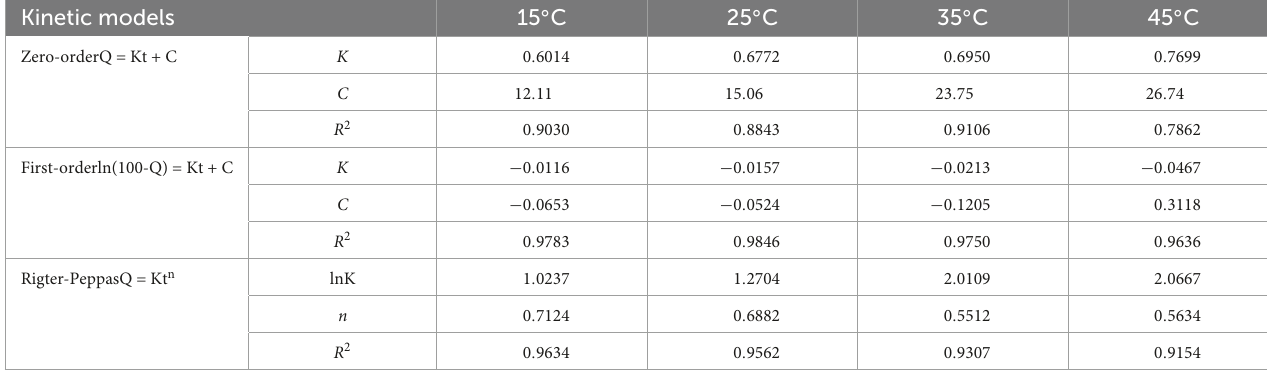
TABLE 2 Release kinetics of Perilla essential oil microcapsules (PEOM) at different ambient temperatures. Kinetic models